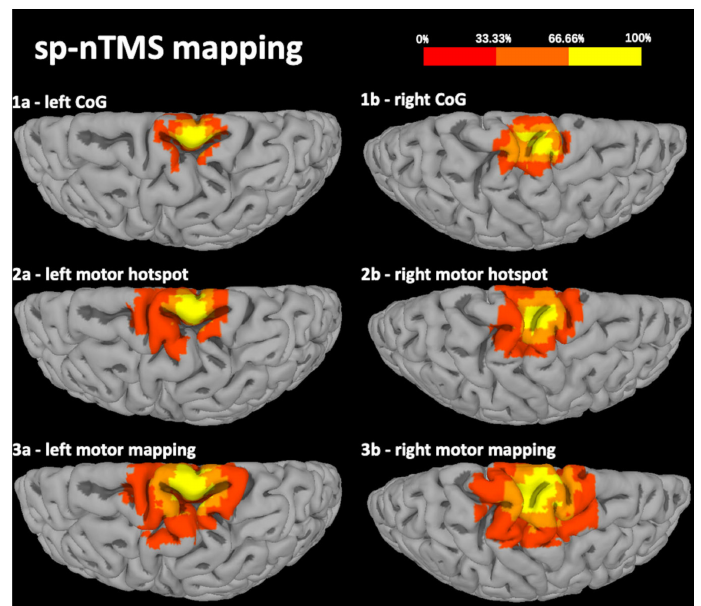
Figure 1. Heat map of the distribution of the center of gravity (CoG), motor hotspot, and total extent of the motor map for single-pulse navigated transcranial magnetic stimulation (sp-nTMS). This figure shows a heat map of the spatial distribution of the CoG location ( 1a , 1b ), motor hotspot ( 2a , 2b ), and extent of the motor map ( 3a , 3b ) of lower extremity (lE) muscle representations, projected onto a brain template after transformation of coordinates into standard space. Results are derived from motor mapping using sp-nTMS with biphasic pulses. The color coding represents the proportion of patients (0–100%).